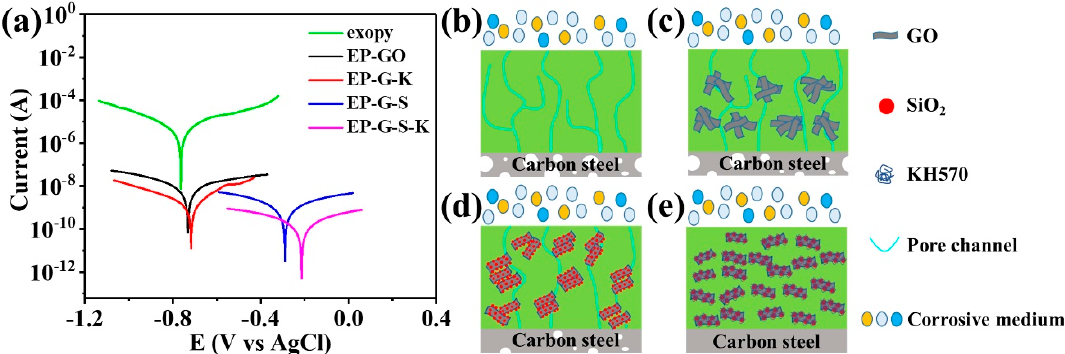
Figure 8. ( a ) Potentiodynamic polarization curves of epoxy, EP-GO, EP-G-S, and EP-G-S-K coatings. Schematic illustration of the barrier effect of ( b ) epoxy, ( c ) EP-GO, ( d ) EP-G-S, and ( e ) EP-G-S-K coatings to Q235 carbon steel.